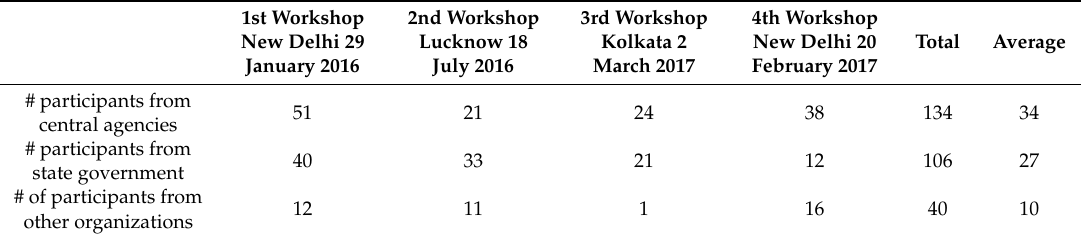
Table 3. Participation of national-level and state-level organizations in basin-wide workshops.